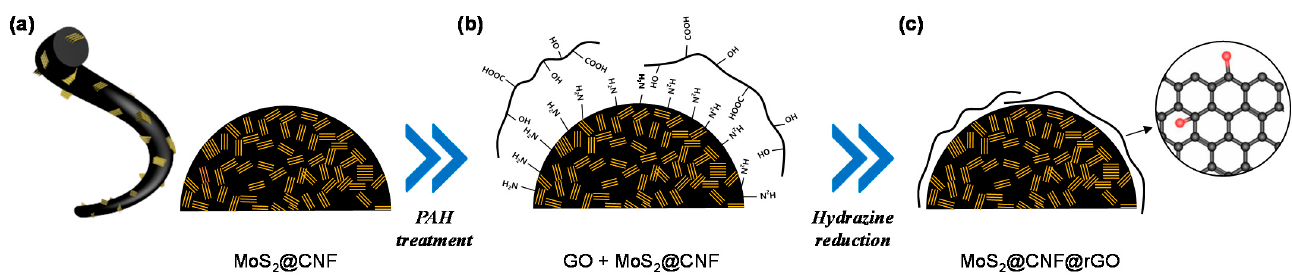
Figure 1. Schematic illustration for preparation of MoS 2 @CNFs@rGO. ( a ) Fabrication of MoS 2 @CNFs synthesized by thermolysis after electrospinning. ( b ) Electrostatic interaction between PAH-modified MoS 2 @CNFs and GO. ( c ) The final product of rGO-wrapped MoS 2 @CNFs achieved after hydrazine reduction.